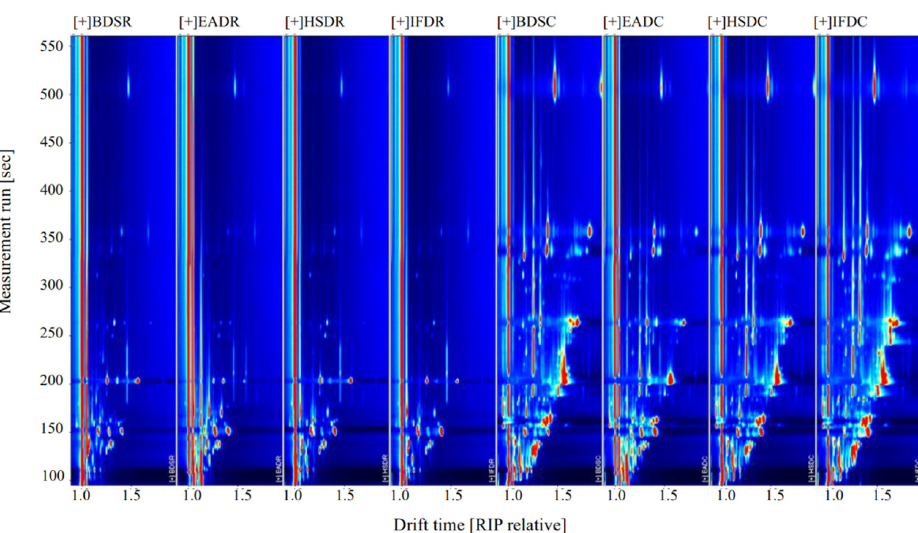
Figure 2. Ion migration spectra from gas chromatography-ion mobility spectrometry (GC-IMS) of raw (R) and cooked (C) sea bass subjected to different slaughter methods. IFD, ice faint to death;